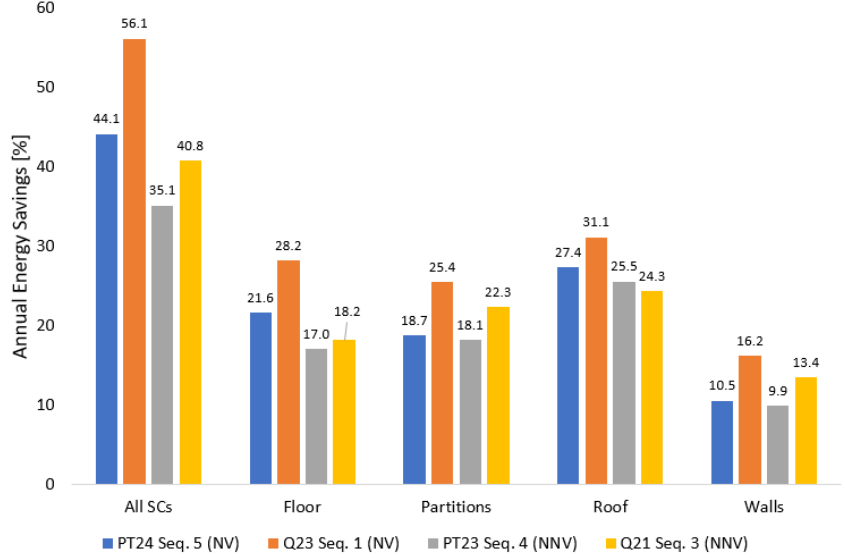
ff erent equipped surfaces of building